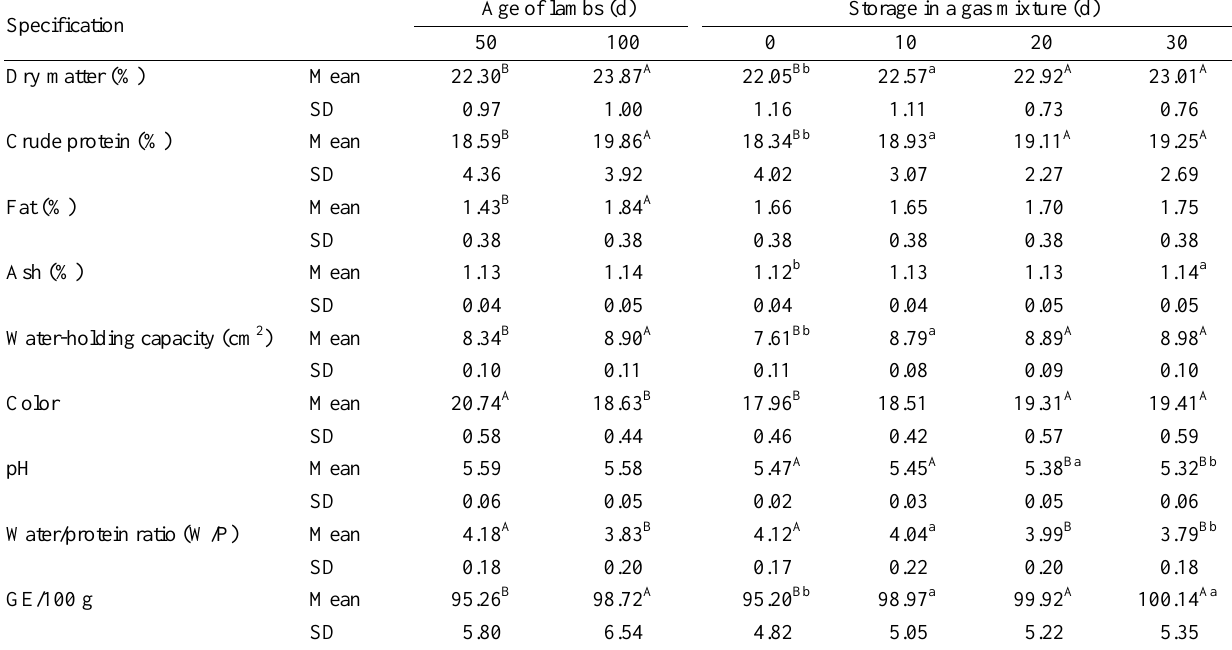
Table 1. Chemical composition and physicochemical properties of meat